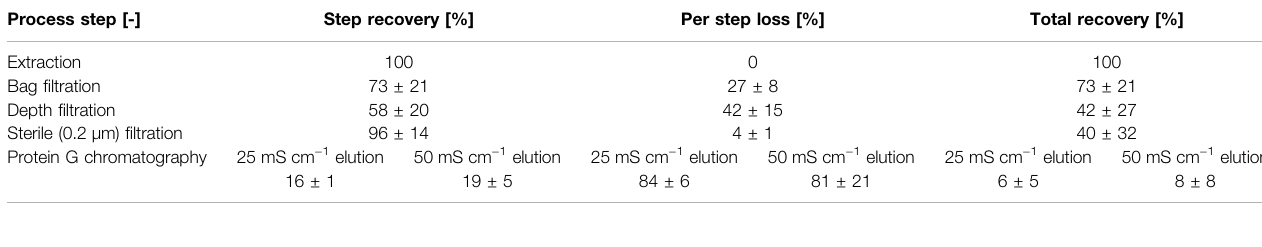
TABLE1| OverviewofpersteprecoveriesandtotalIgG3recoveriesduringIgG3puri fi cationfrom N.benthamiana extracts.Dataaremeans ± standarddeviationsfrom n (cid:2) 4 (extraction to sterile fi ltration) or n (cid:2) 2 (protein G chromatography) puri fi cation processes. Process step [-]